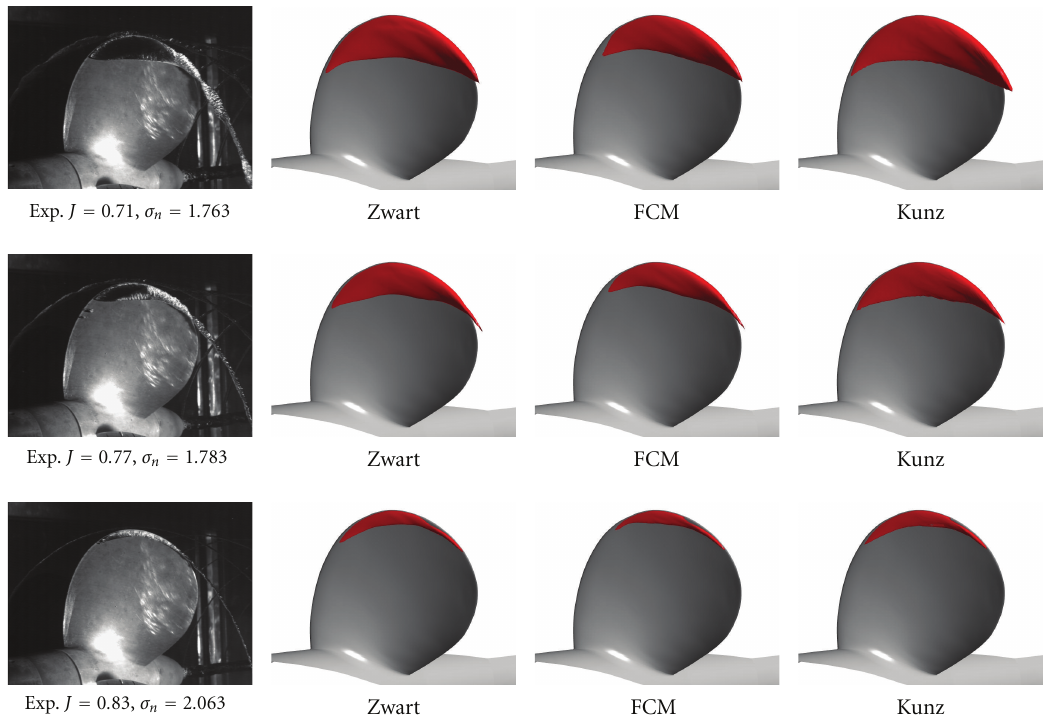
Figure 11: Comparison of the cavitation patterns for three di ff erent operational conditions for the E779A propeller. The numerical cavitation patterns, obtained using the three di ff erent mass transfer models, are depicted as isosurfaces of vapour volume fraction α = 0 . 5. The relative percentage errors of the computed K T , K